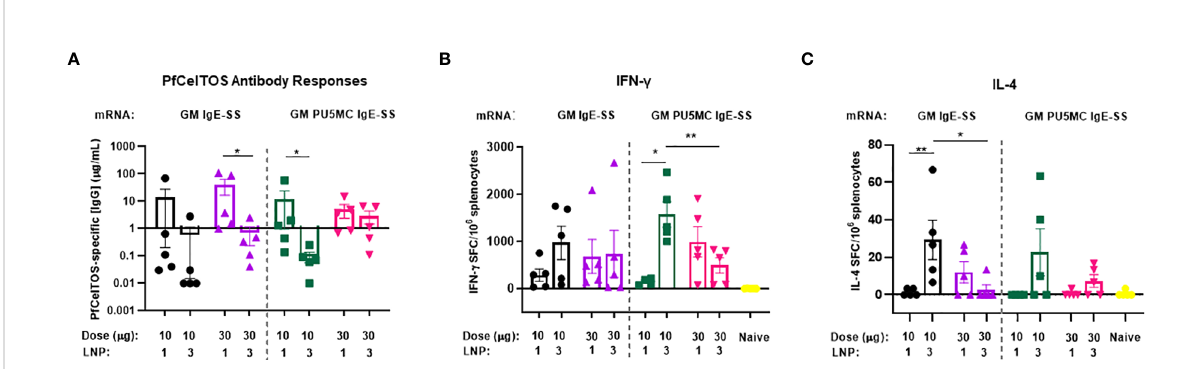
FIGURE 3 Effect of mRNA dose and nucleoside modi fi cation on immune responses. BALB/cJ mice were immunized intramuscularly (IM), two times at three-week intervals, with a low dose (10µg) or a high dose (30µg) of pfceltos mRNA that was N-glycosylation site modi fi ed (GM), containing human IgE signal sequence (IgE-SS) (GM IgE-SS), and with nucleoside y -pseudouridine and 5 ’ -methylcytosine substitutions (PU5MC), (GM PU5MC IgE-SS), in LNP (LNP1 or LNP3), ( n= 5 per group). (A) Antigen-speci fi c IgG antibody concentrations against PfCelTOS were quanti fi ed in sera two weeks after the fi nal dose by ELISA. Antibody concentrations are represented as the mean and standard deviation (SD). Statistical analysis was performed using an unpaired t-test (*p<0.05). (B, C) IFN- g and IL-4 cytokines were detected by ELISpot. The mean number of spot-forming cells (SFC) per splenocytes were reported with standard errors of the mean (SEM). Statistical analysis was performed using Mann- Whitney test, (*p<0.05,